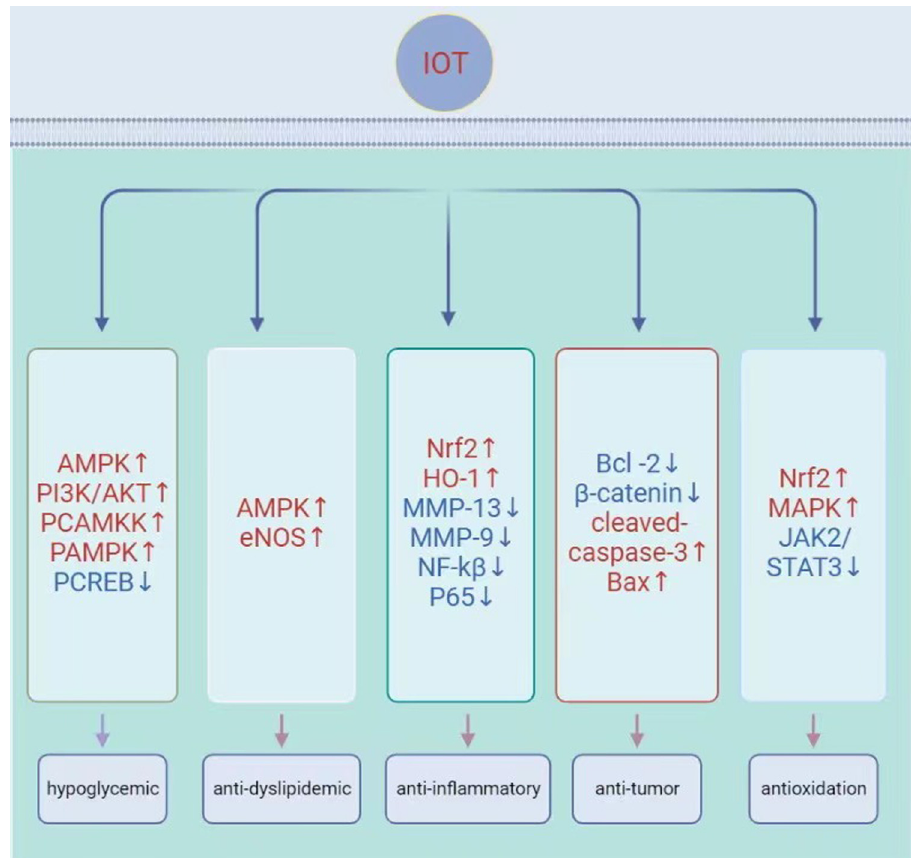
Figure 1: Molecular mechanisms for biological activities of triterpenoids from Inonotus obliquus . Hypoglycemic e ff ects were induced by regulating PI3K/AKT and AMPK/ACC signaling pathways. The antidyslipidemic e ff ects could be inhibited by IOT through increased AMPK/ eNOS signaling pathway. ROS - mediated in fl ammation induced by stress/stimuli could be inhibited by IOT through inhibition of the NF - κ B/ p65 signaling pathway, particularly the phosphorylation - induced I κ B degradation step which can prevent NF - κ B from DNA binding. The antitumor e ff ect is mainly to improve the apoptosis index. The ROS could be inhibited by IOT through inhibition of the JAK2/STAT3 signaling pathway and increased MAPK/Nrf2 signaling pathway. IOT, triterpenoids from Inonotus obliquus. ROS, reactive oxygen species. PI3K/Akt: PI3K, phosphatidylinositol - 3 - kinase; Akt, protein kinase B. AMPK/ACC: AMPK, adenosine monophosphate activated protein kinase; ACC, acetyl - CoA carboxylase. AMPK: adenosine monophosphate activated protein kinase. NF - κ B: nuclear factor ( NF )- κ